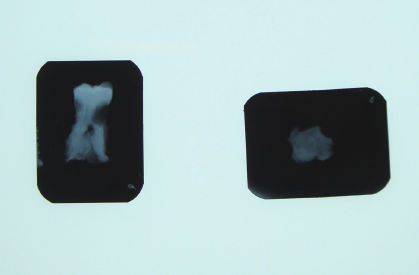
Figure 1: Intraoral periapical radiograph of the lower right mandibular region showing a coronal and radicular radiolucency involving the pulp of the right mandibular first molar and a root stump of the adjacent second premolar region. The roots of the second premolar and the first and the second molars were bulbous with an irregular outline.